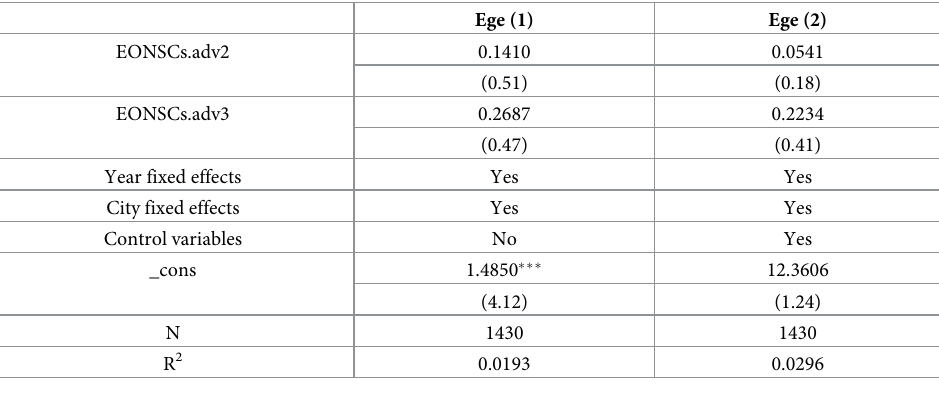
Table 4. Placebo test